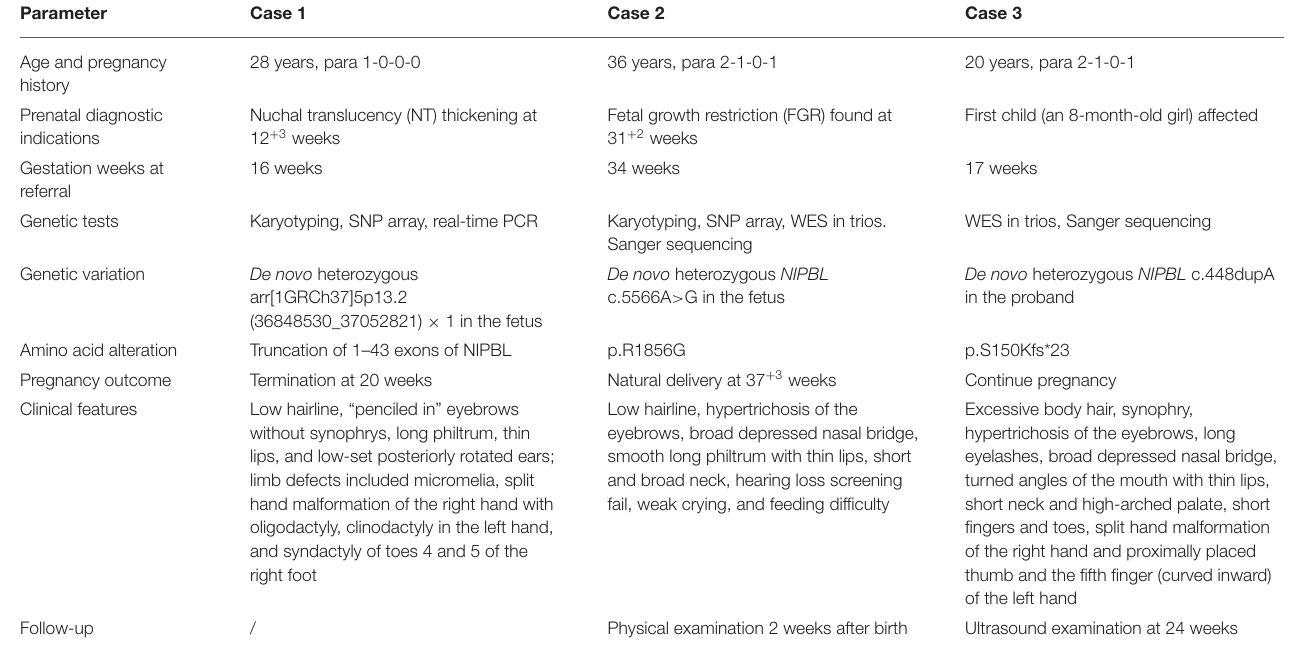
TABLE 1 | Comparison of the three cases of Cornelia de Lange syndrome